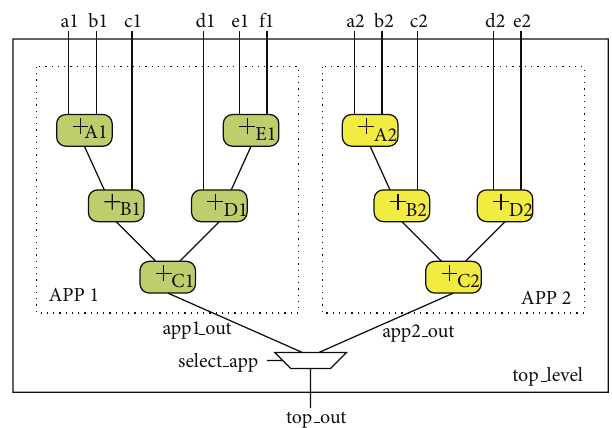
Figure 6: Two mutually exclusive applications: APP1 and APP2.